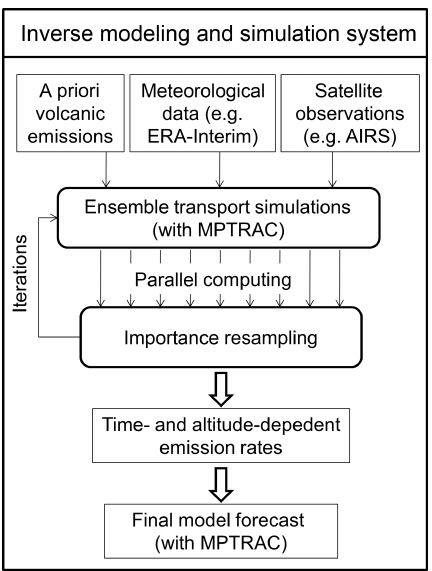
Figure 1. Flow chart of the proposed inverse modeling and simu- lation system to infer volcanic SO 2 emissions rates and to perform transport simulations.